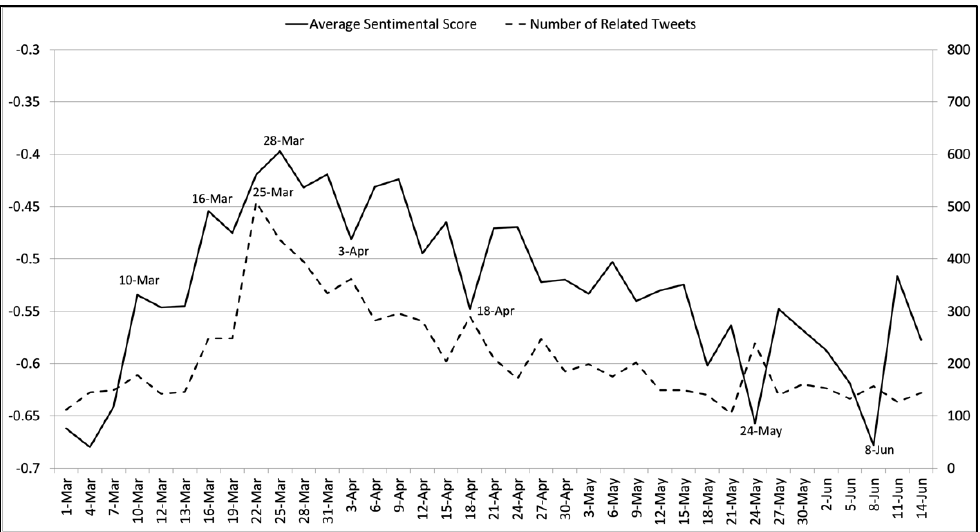
Figure 5. The average sentiment scores and the numbers of tweets related to the social distancing policy on each collection day from 1 March 2020 to 14 June 2020. The left vertical axis indicates average sentiment scores, while the right vertical axis suggests the number of related tweets col- lected. The horizontal axis shows the collection dates.